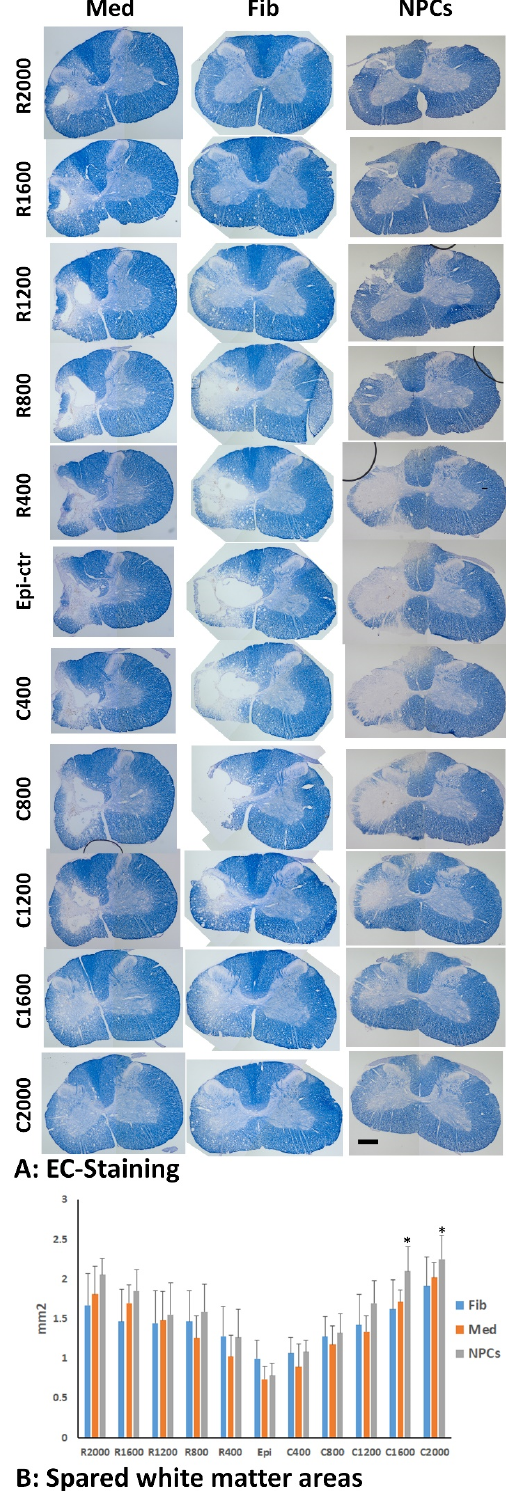
Figure 6. Spared white matter after transplantation of hiPSC-NPC. Spared white matter (WM) in the injured side was quantified using EC-staining at 2 months after transplantation ( A ). The spared WM areas were significantly greater in caudal 1.6 and 2 mm from injury epicenter in rats receiving NPC grafts compared to groups receiving human fibroblasts ( B ). Scale bar: ( A ), 500 µ m. Data in ( B ) represent the man ± SD (n = 5), * p <